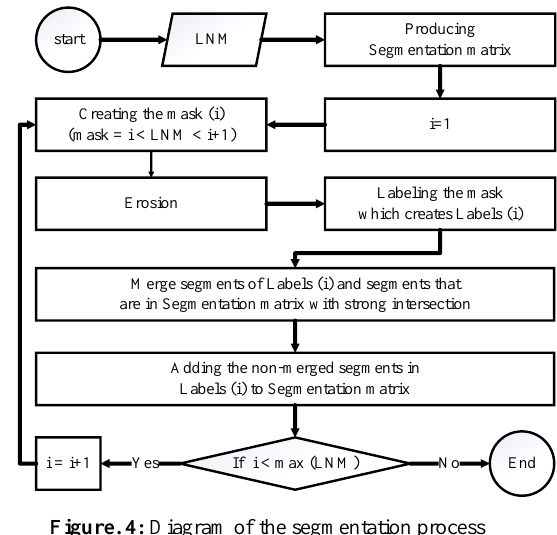
Figure. 4: Diagram of the segmentation process 3.2 Labelling the door candidates This step analyses the part of the point cloud corresponding to each door candidate independently and decides whether it is a door or not. Hereinafter, this part of the point cloud is called a candidate's cloud. A door frame is an empty cubic shape inside the point cloud consisting of two horizontal and two parallel vertical planes. The door itself is also a vertical plane that its orientation about the frames' vertical planes could be parallel, perpendicular, or neither. So, detecting the door itself could be problematic, which is why our method tries to detect doors using the door frame's planes only and based on the histogram of the candidates' cloud coordinates. Figure 5 compares two opened and closed doors and highlights the mentioned planes. This figure highlights the door fames' horizontal and vertical planes in green Figure 3. Schematic representation of how labels will be and red. Also, the door itself is shown in blue. merged. (a) . Labelled mask 1 (b) . Labelled mask 2. (c) Merged labels